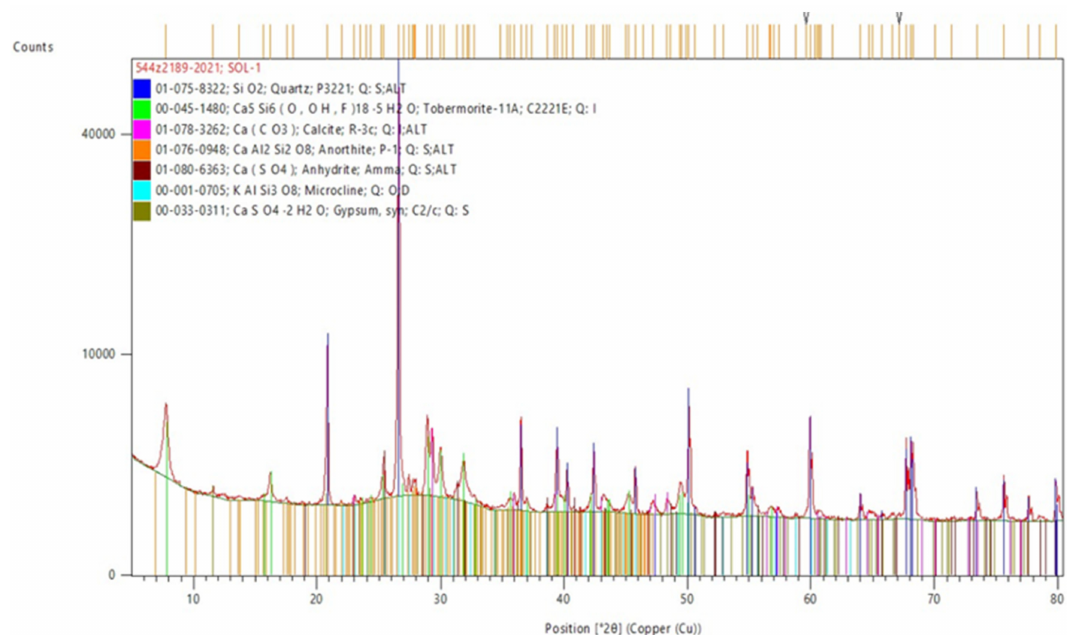
Figure 7. Phase composition of autoclaved cellular concrete.